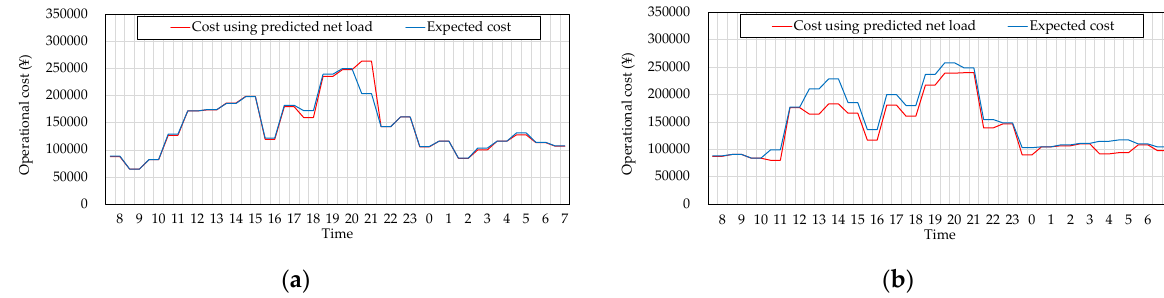
Figure 8. Comparison of costs in optimal solutions: ( a ) Proposed framework; ( b ) Traditional framework (“¥” means “any currency unit is applicable”).